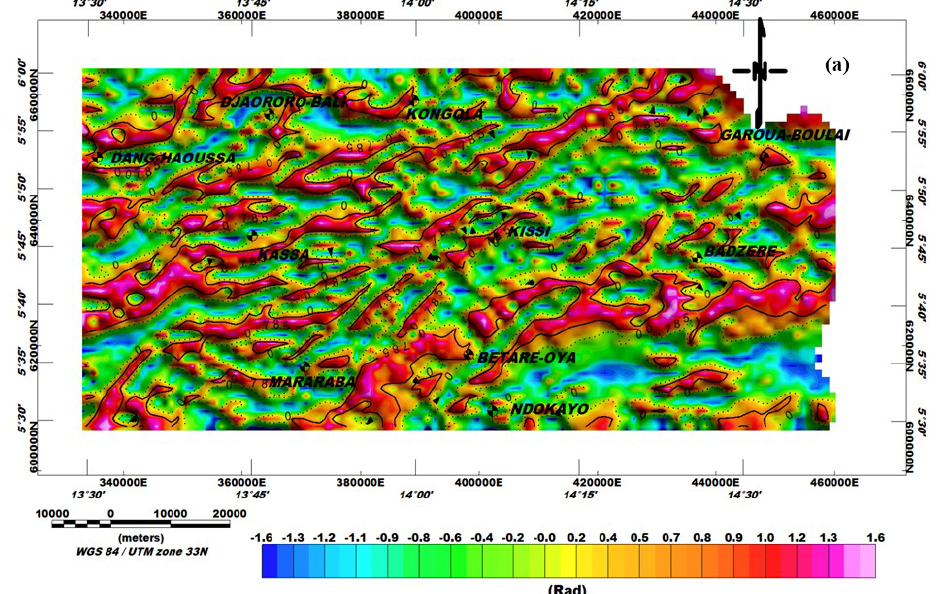
Figure 5. Tilt angle on residual